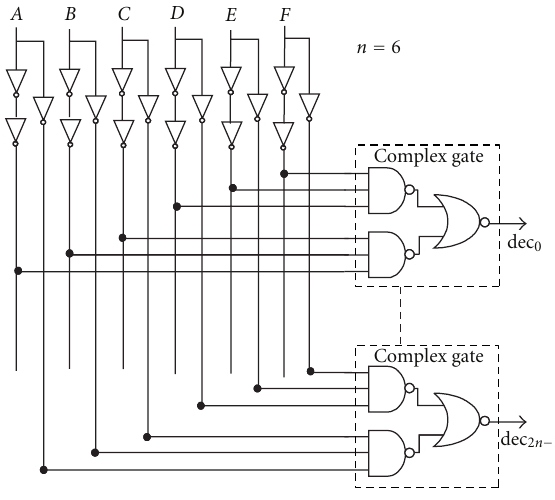
Figure 12: Four-state data encoding.